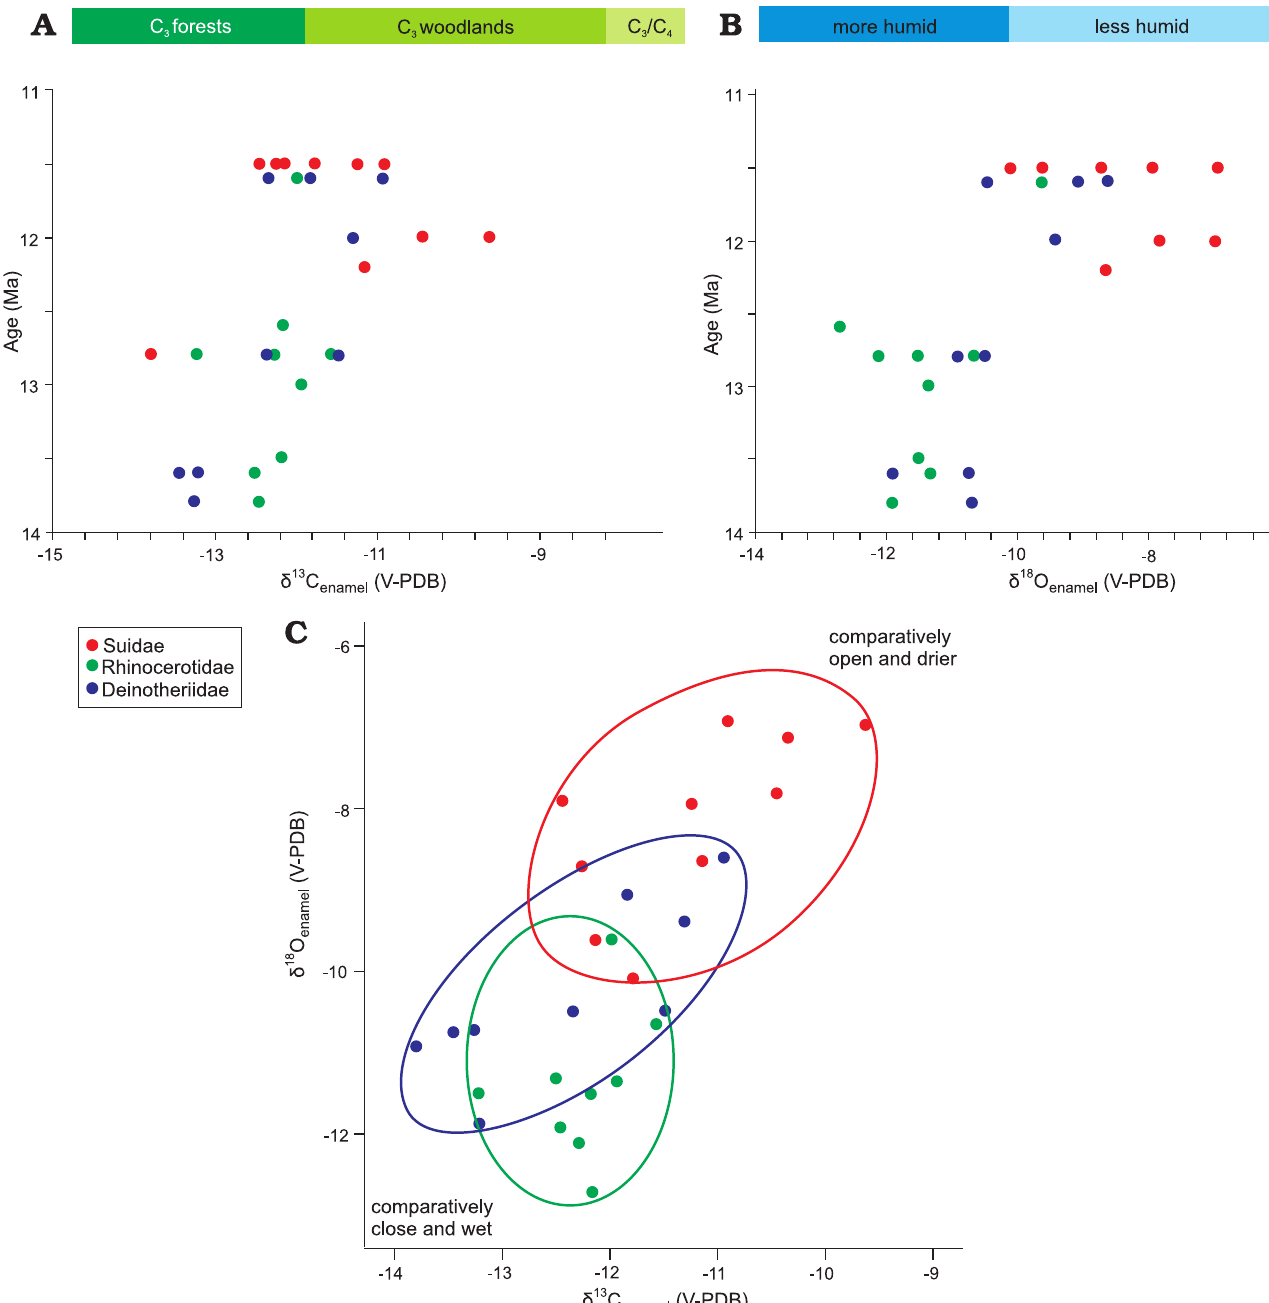
Fig.­2.­δ 13 C enamel ­and­δ 18 O enamel of all results on three herbivore families from the Chinji Formation. A .­δ 13 C enamel values versus age (Ma) showing close and forest ecology of middle Miocene. B .­δ 18 O enamel values versus age (Ma) indicating the moisture conditions in middle Miocene. C . The niche partition- ing­in­δ 18 O enamel ­versus­δ 13 C enamel space among the suids, rhinocerotids, and